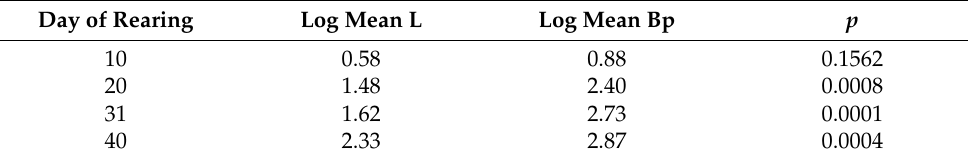
Table 4. Logarithmic mean of the number of pests in the “critical points”. Day of Rearing Log Mean L Log Mean Bp p 10 0.58